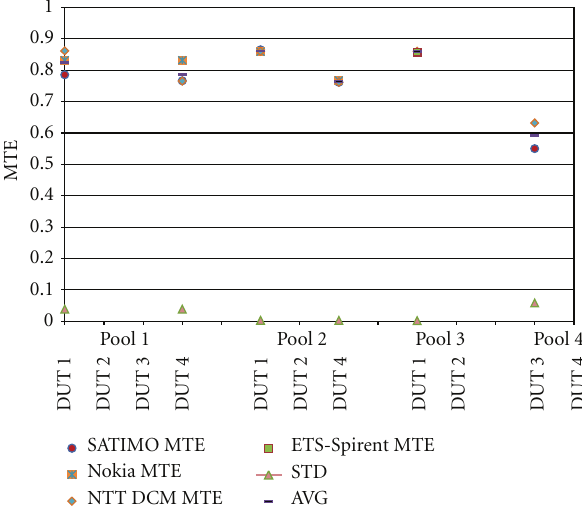
Figure 11: MTE for the AC methodology.